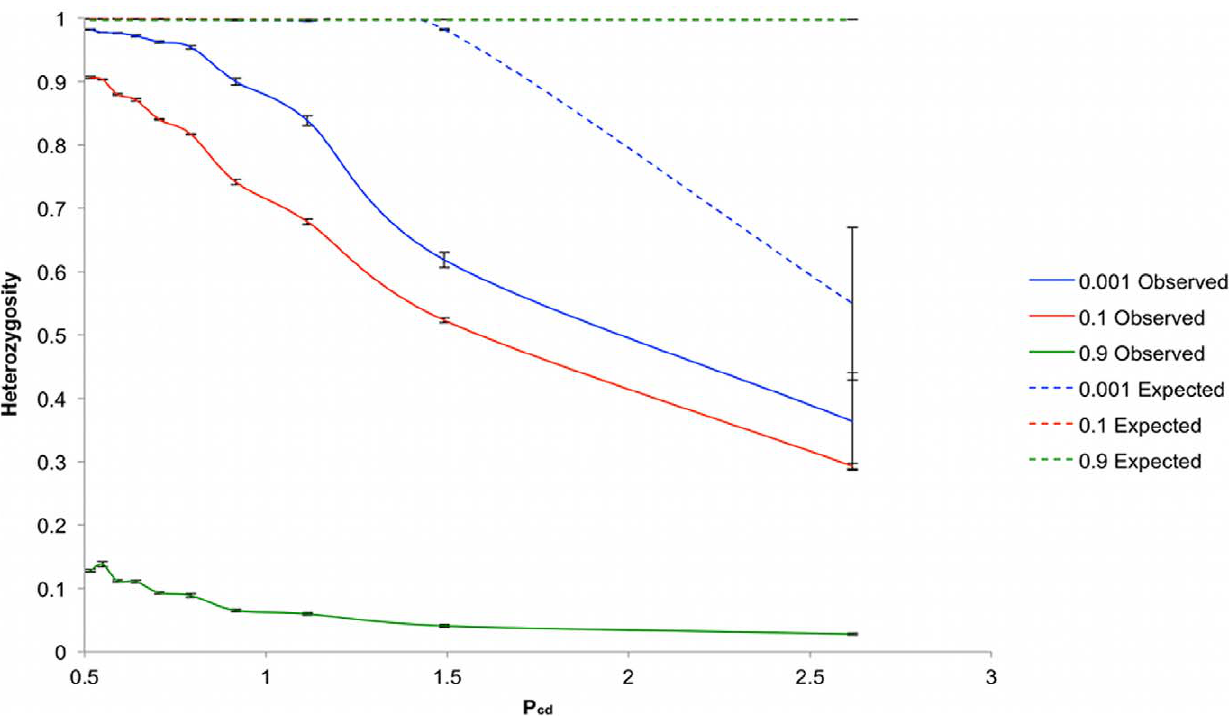
Figure 4. Heterozygosity as a function of P cd . Heterozygosity was plotted at S u =0.001 (blue), S u =0.1 (red) and S u =0.9 (green). H o is plotted with the solid line and H e using a dashed line. Simulations were repeated ten times for each value of S u , with error bars representing the standard error.